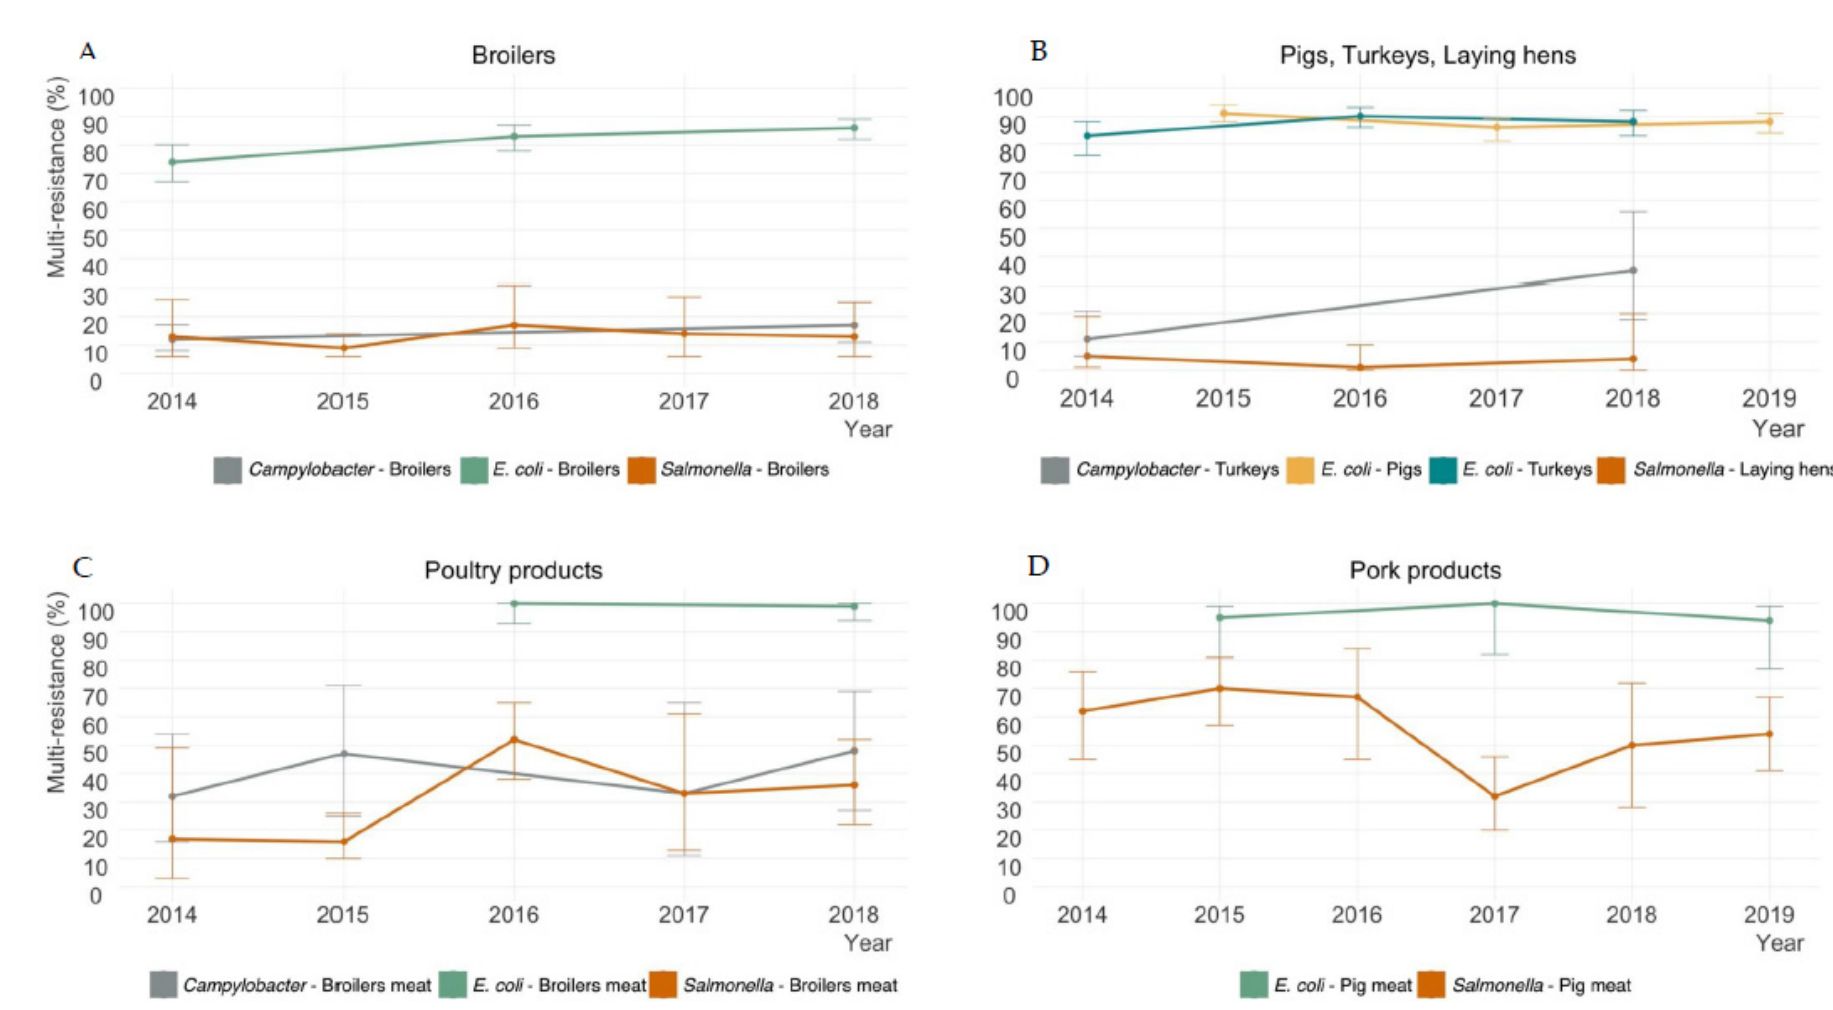
Figure 1. Multi-resistance in bacterial isolates collected from animal populations ( A , B ) and food products ( C , D ), 2014–2019.